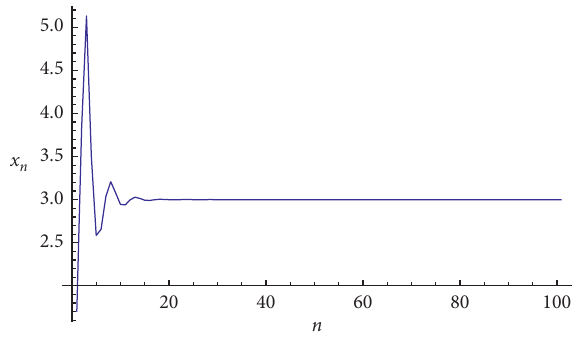
Figure 1: Phase portrait of equation (8) with x